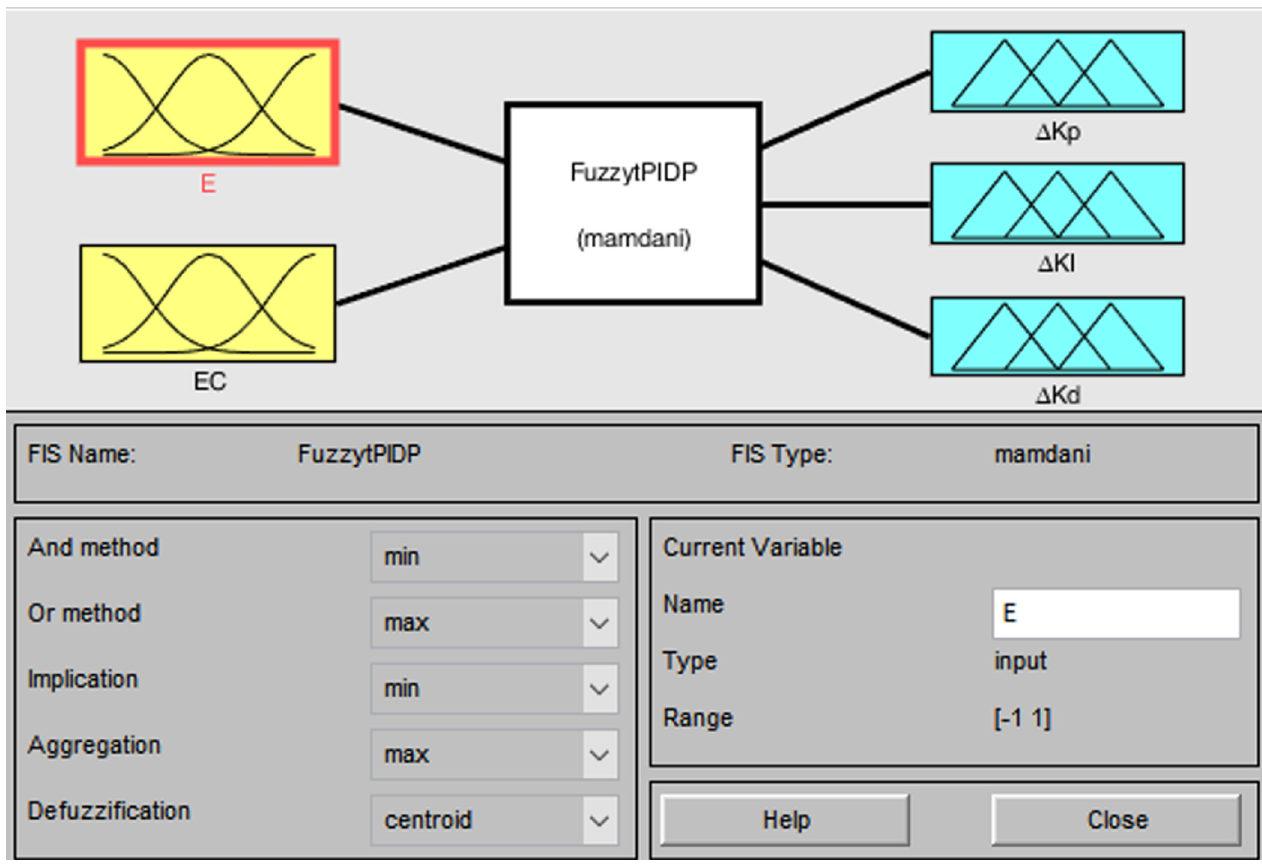
Fig. 8. Fuzzy controller.